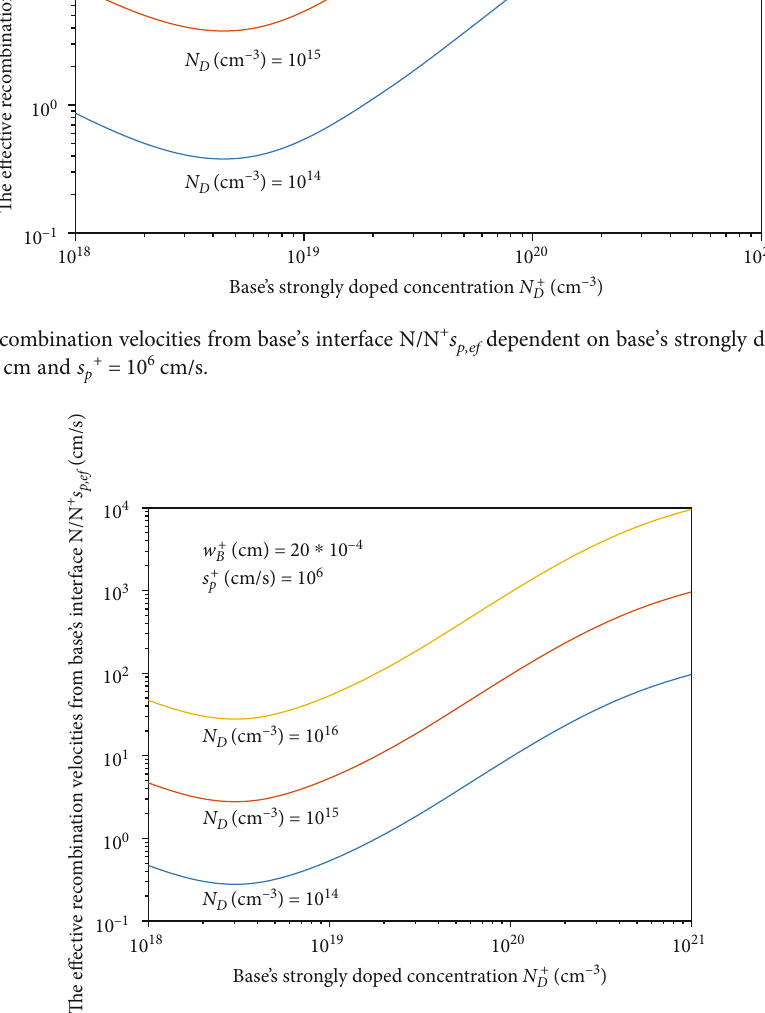
Figure 15: The e ff ective recombination velocities from base ’ s interface N/N + s the case of w B + = 20 × 10 − 4 cm and s p + = 10 6 cm/s